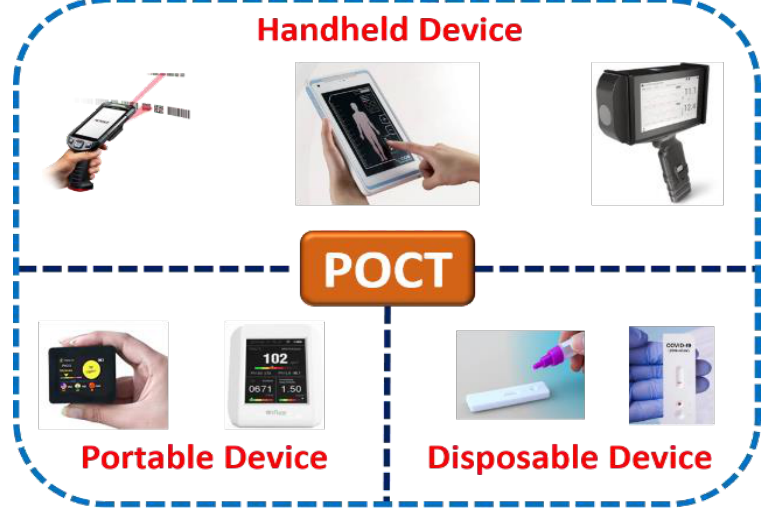
Figure 2. Classification of point-of-care-testing (POCT) microdevices.